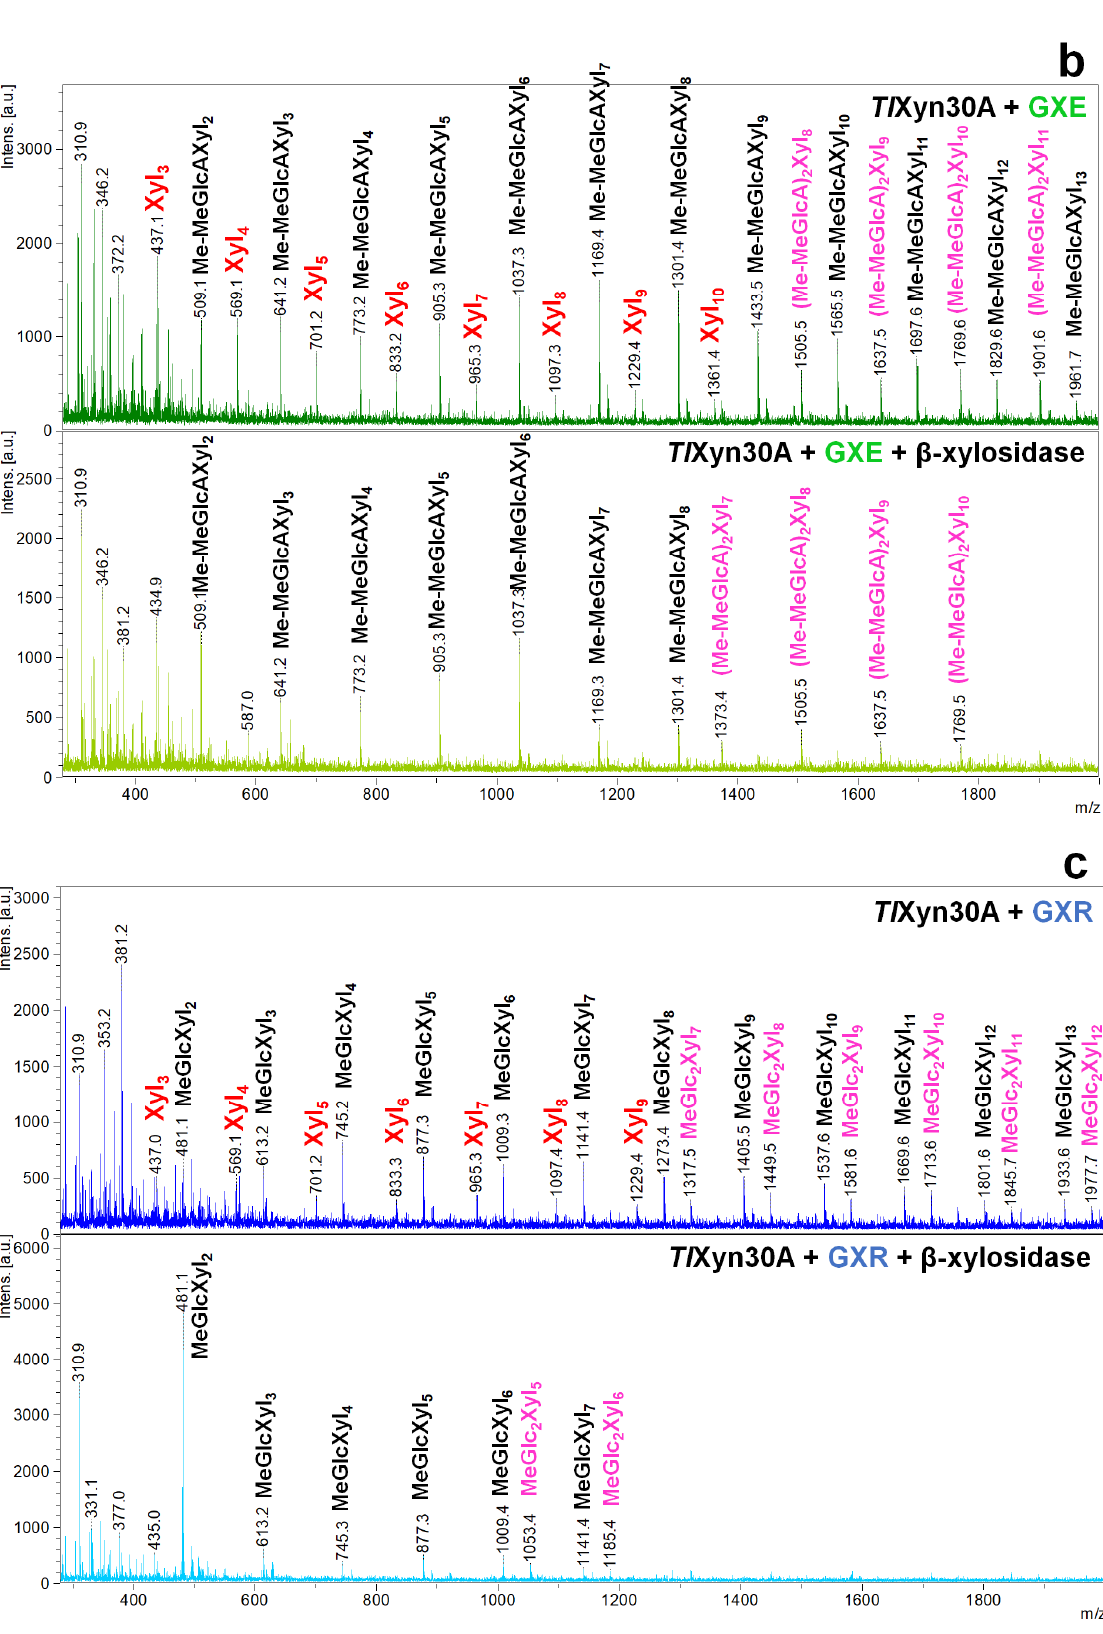
Figure 3. MALDI ToF MS analysis of the hydrolysates of GX ( a ), GXE ( b ) and GXR ( c ) generated by Tl Xyn30A and their subsequent hydrolysis by β -xylosidase.